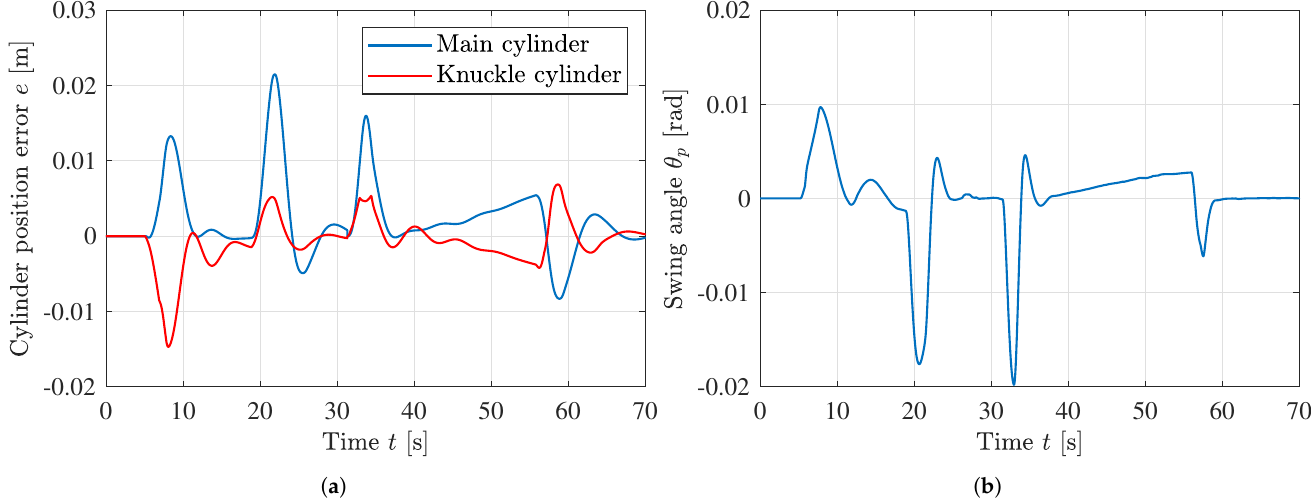
Figure 35. Cylinder position error and swing angle during motion with EHAs. ( a ) Cylinder position error; ( b ) Swing